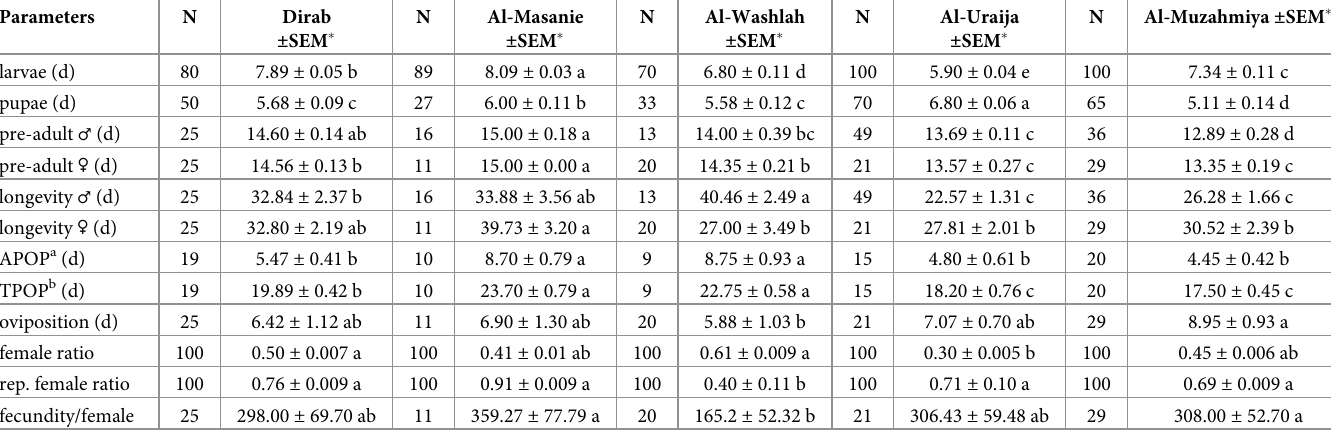
Different letters in each row indicate significant differences among the populations (paired bootstrap test, P � 0.05) using TWO-SEX MS chart program. � Standard errors of means (SEM) were estimated using bootstrapping (100,000 re-samplings). N = cohort size, d = days, rep. = reproductive a adult pre-oviposition period b total pre-oviposition period.